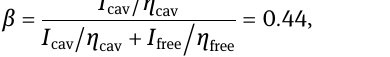
Figure 4: Spectrum of coupled emitter-cavity system at cryogenic temperatures. Cavity